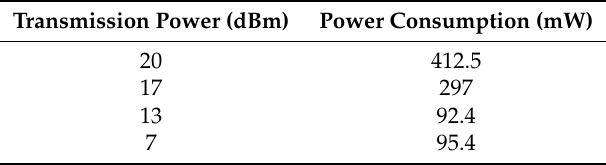
Table 3. LoRa SX1272 characteristics.